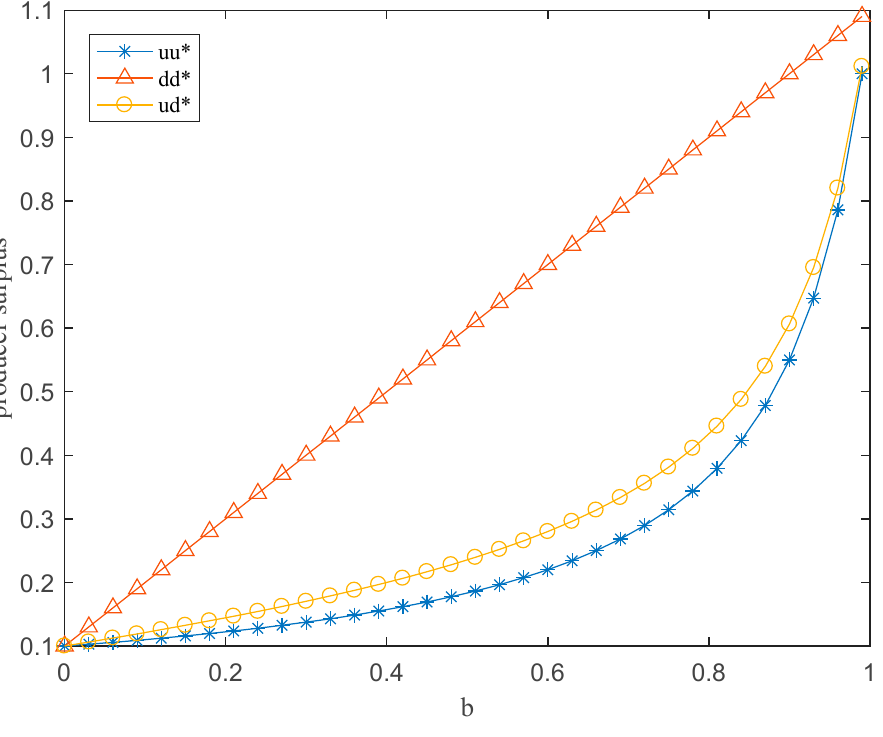
Figure 1. The total consumer surplus under different situations.